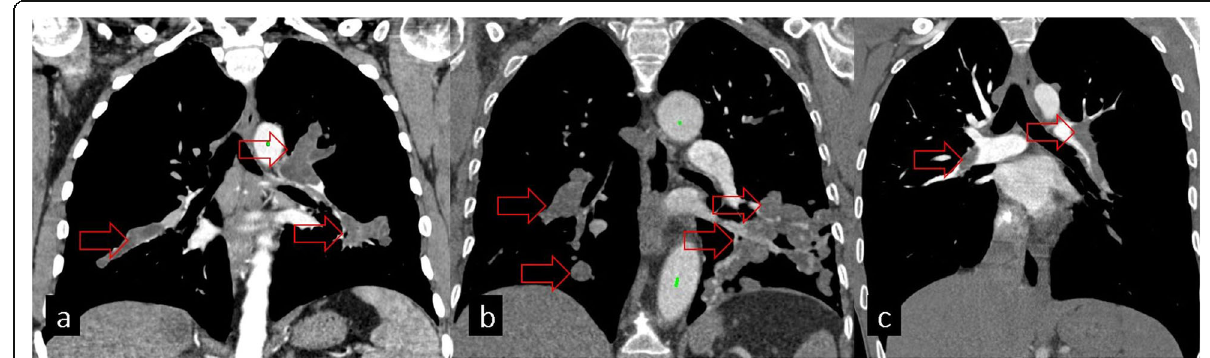
Fig. 17 a Hydatid cysts of pulmonary arteries seen on the coronal chest CT image. b Sarcoma of the pulmonary artery shows vascular distension and fills the lumen like hydatid cysts of the pulmonary arteries. c Pulmonary thromboembolism as another differential diagnosis of hydatid cyst seen on the coronal chest CT image